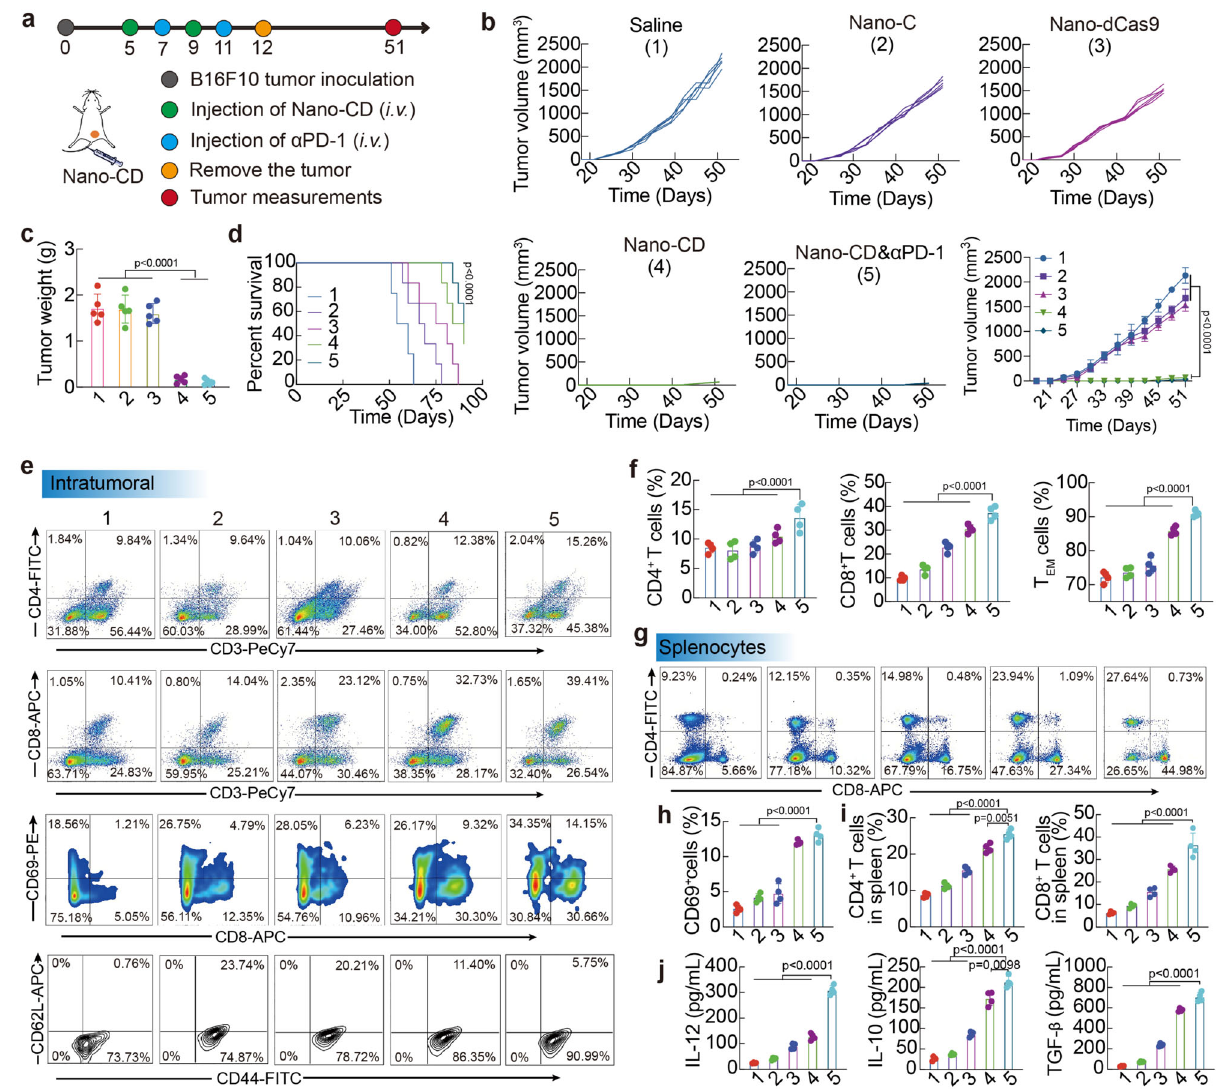
Fig. 6 | Anti-tumor effect of Nano-CD against recurrence melanoma model. a Scheme of mice treated with different formulations. b Tumor volume ( n =5 biological replicates per group), tumor weight ( n =5 biological replicates per group) ( c ) and survival curve (log-rank test, n =6 biological replicates per group, Nano-CD vs. Saline) ( d ) of tumor-bearing mice with different treatments. e – i Pro fi les and percentages of CD4 + T cells, CD8 + T cells, CD69 + activated T cells,